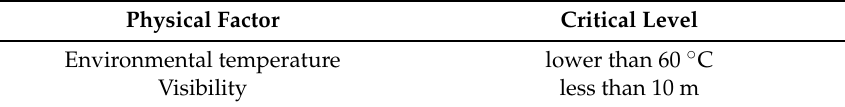
Table 2. Safety standards in a fire in